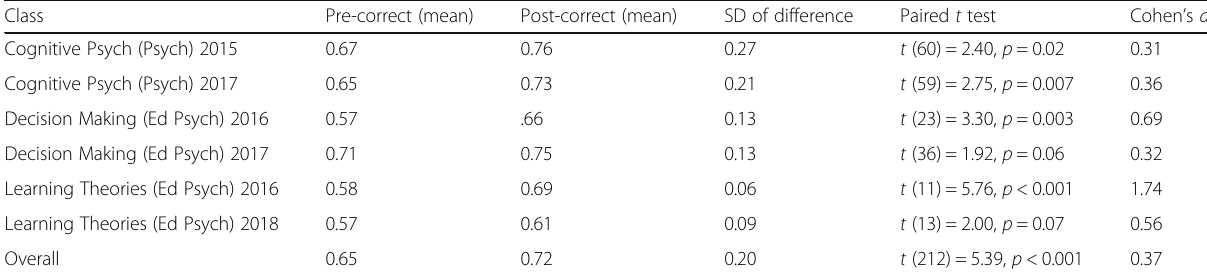
Table 3 Accuracy before and after discussion by class